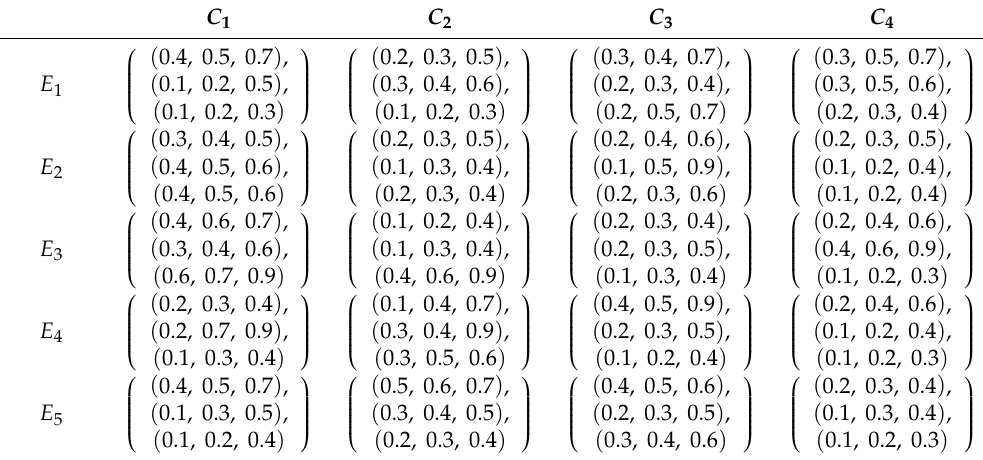
Table 3. TFNNs judgement matrix by the decision maker d 3 .